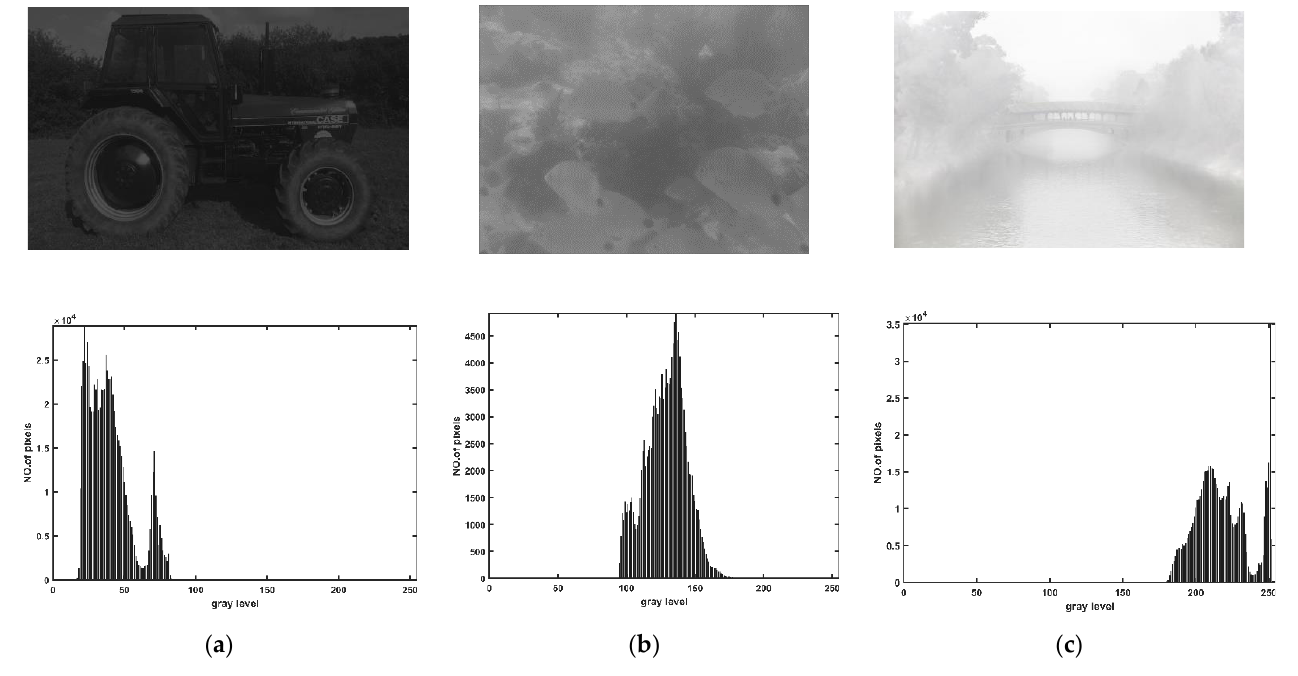
Figure 8. Original images and their corresponding histograms: ( a ) Image “ Tractor ” ; ( b ) Image “ Fish ” ( c ) Image “ Bridge ”